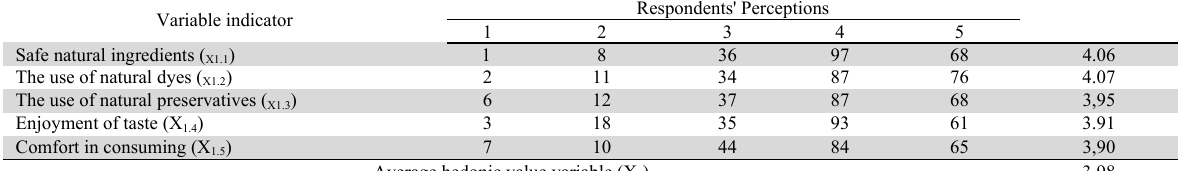
Description of Respondents' Perceptions of Hedonic value Indicators (X 1 )